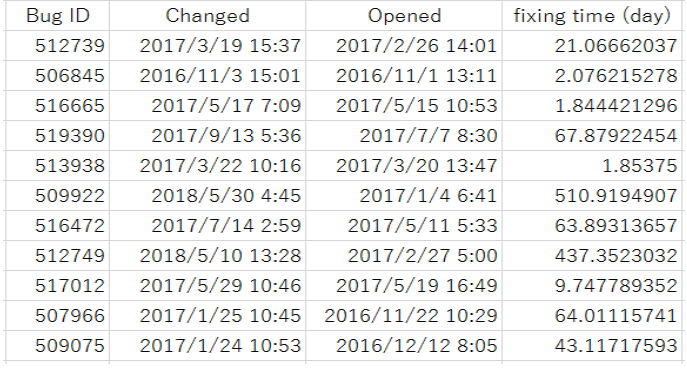
Figure 2. A part of the dataset used in this